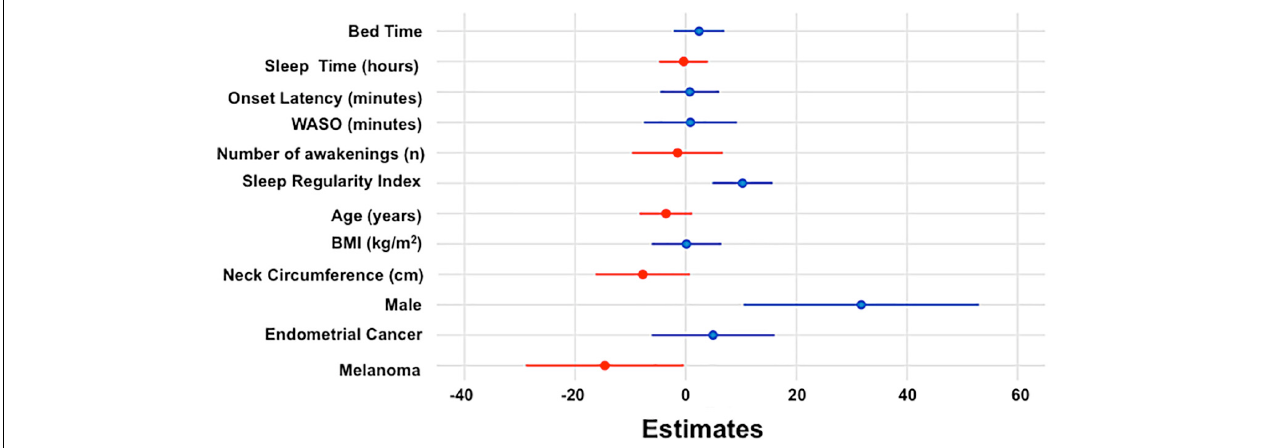
FIGURE 3 | Estimated regression coefficients (dots) with 95% confidence intervals (bars) from linear regression model for QoL are shown with positive and negative coefficients represented in blue and red,